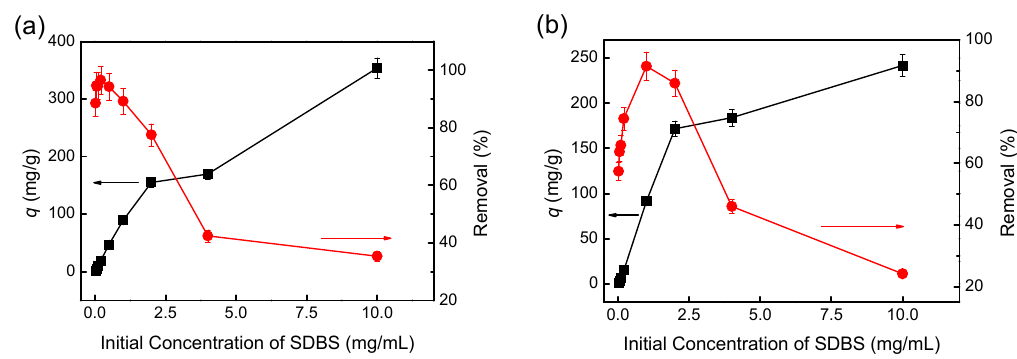
Figure 6. Changes in SDBS adsorption efficiency of ( a ) HP20 and ( b ) HP2MGL in SDBS/Cs with adsorption time at various concentrations of adsorbents. [SDBS] = 0.1 mg/mL.